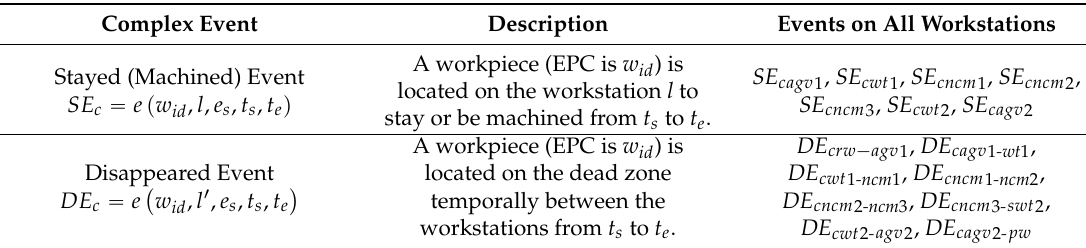
Table 2. Complex events used in this